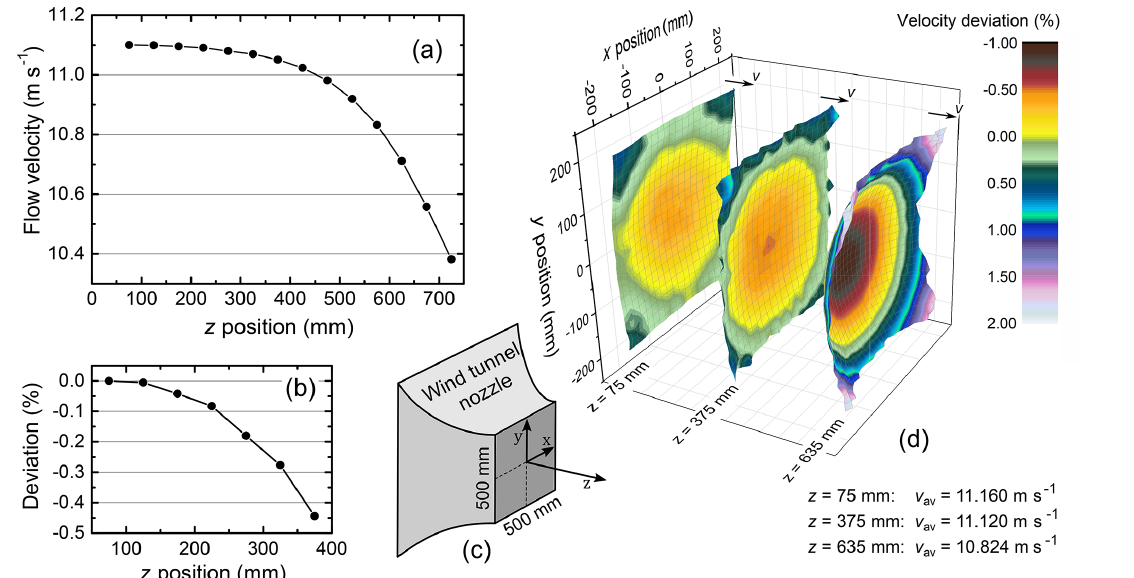
Figure 11. Homogeneity of the wind tunnel: (a) flow velocity along the z axis of the test section ( x = y = 0mm) at constant wind tunnel flow speed and (b) corresponding deviation in % for z < 375mm. (c) Sketch of wind tunnel nozzle with coordinate system, and (d) lateral homogeneity at the beginning, the center and the end of the test section on a cross-sectional area of 400mm × 400mm 2 .